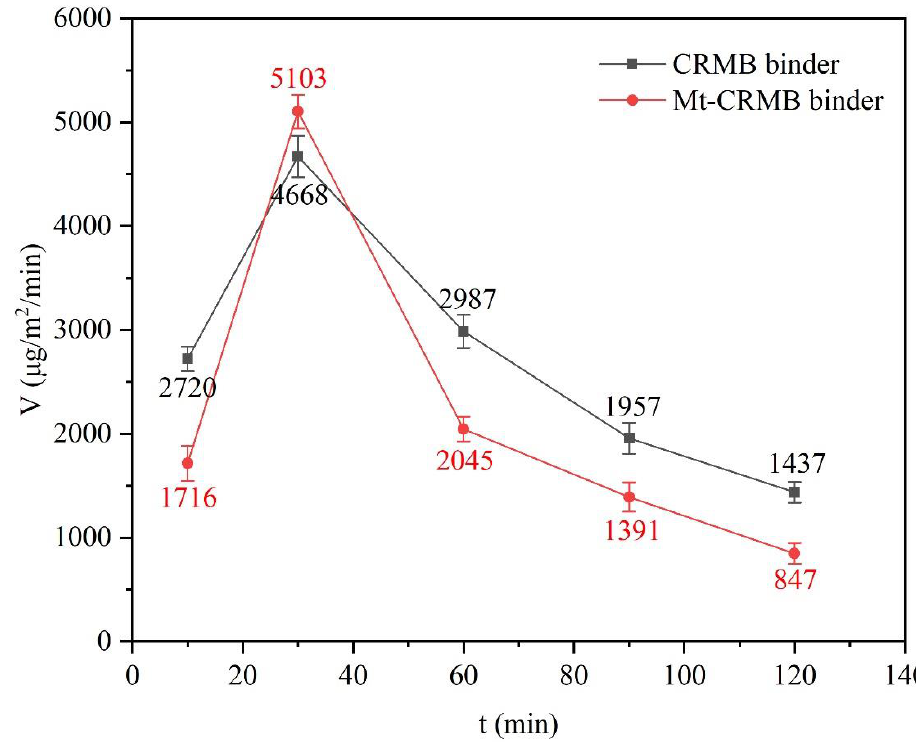
Figure 13. Total VOCs emission rates of CRMB and Mt-CRMB binders.